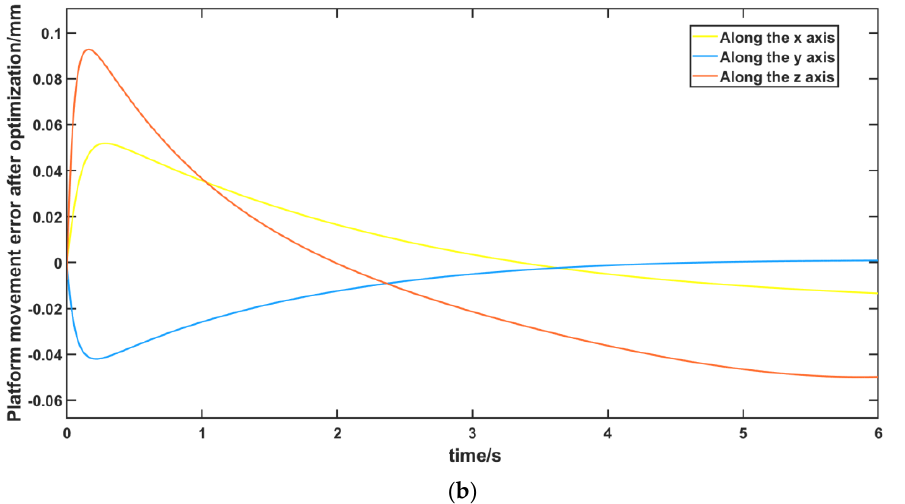
Figure 17. Comparison of the error between the actual motion trajectory and the expected motion trajectory before and after mobile platform optimization: ( a ) comparison of the error between the actual motion trajectory and the expected motion trajectory before mobile platform optimization; ( b ) comparison of the error between the actual motion trajectory and the expected motion trajectory after mobile platform optimization.